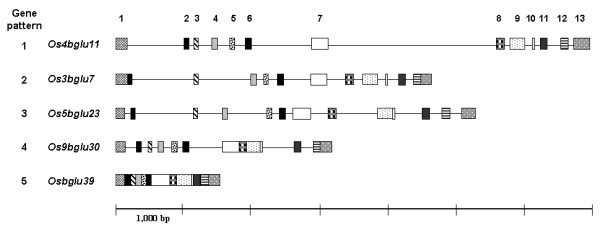
Predicted gene structure patterns for putative rice GH1 β-glucosidase genes. Exons are shown as boxes with corresponding exons having the same pattern. Introns, represented as simple lines, are drawn in proportion to their length. Note that 5 gene organization patterns can be seen in rice genes, those with 13, 12, 11, or 9 exons and intronless patterns, with the splice sites conserved in each group and between groups for common exons and introns.